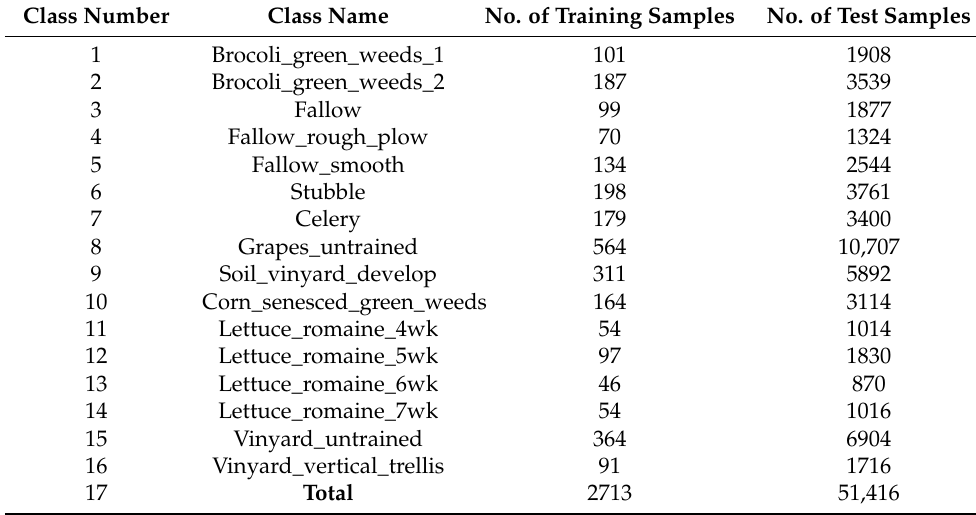
Table 2. Training and test samples of Salinas dataset.